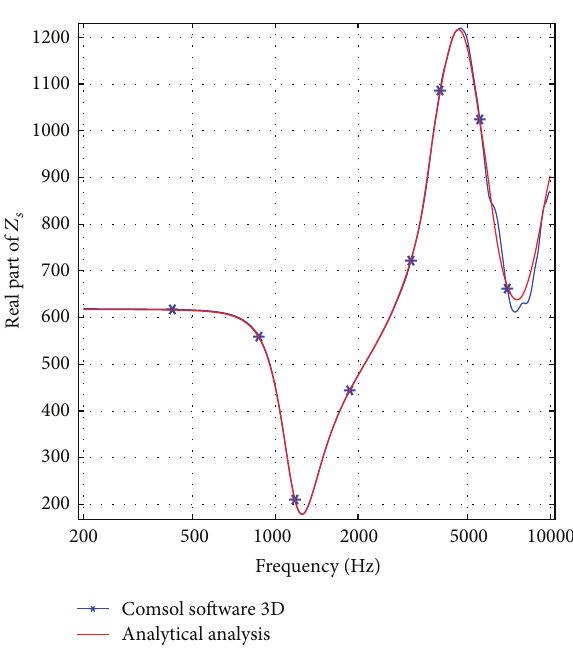
Figure 1: Real part of surface